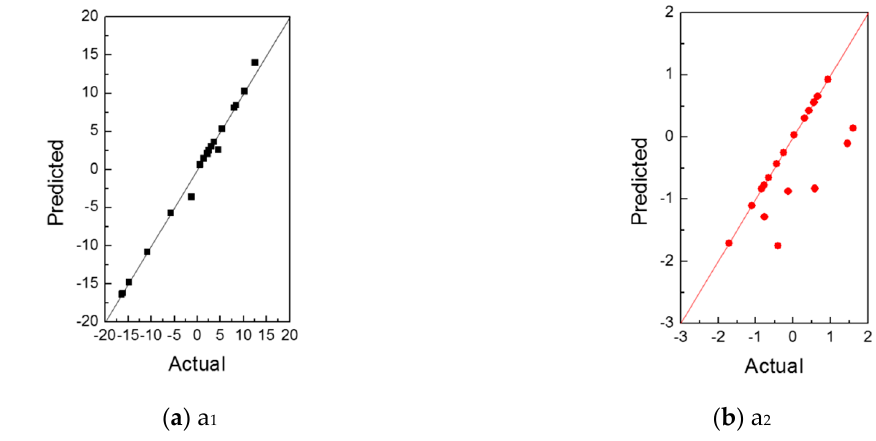
Figure 16. Actual–predicted plot for the weighting coefficients (a) a 1 and (b) a 2 .